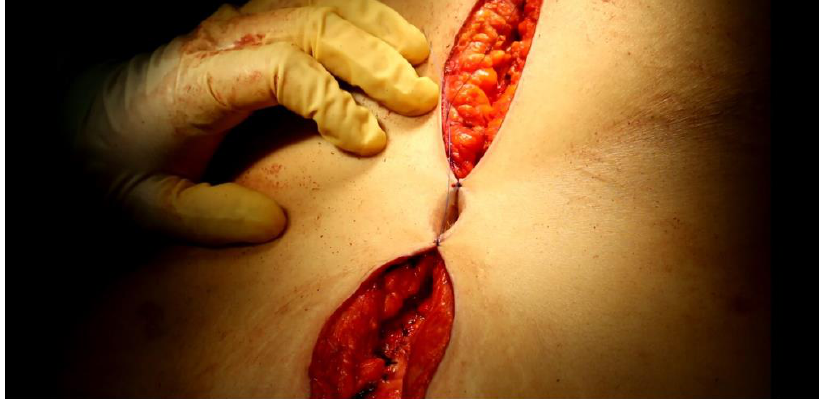
Figure 4. The new navel is now complete.